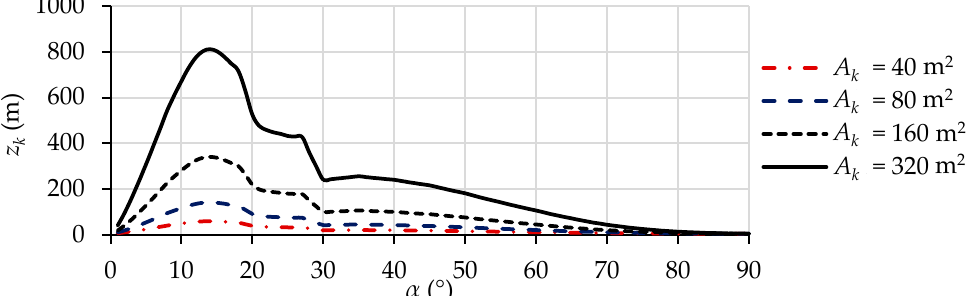
Figure 7. The kite elevations for each kite area and angle of attack at a ship speed of 7.27 m/s and a reference wind speed of 20 m/s.